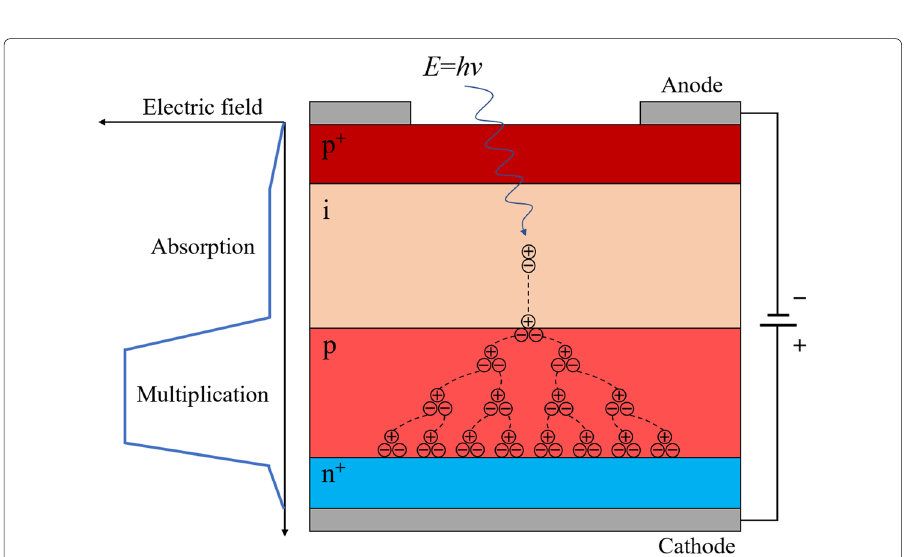
Fig. 1 Avalanche photodiode operating principle. The left part is the electric field profile of the APD and the right part is the schematic of the avalanche